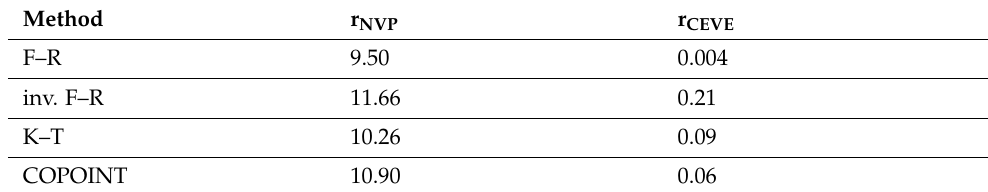
Table 3. Reactivity